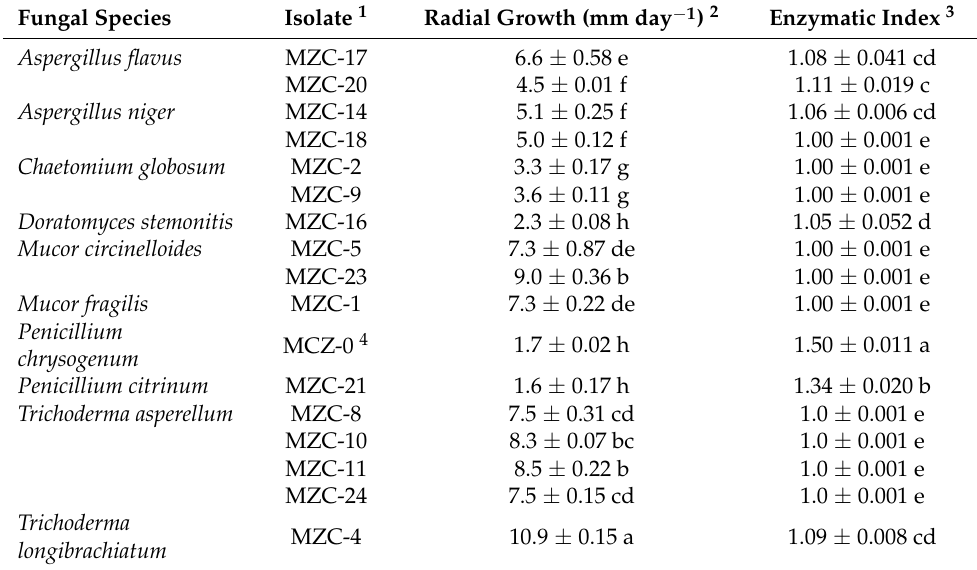
Table 6. Cellulolytic activity of the 16 fungal isolates identified in this study associated with the subterranean termite Reticulitermes grassei